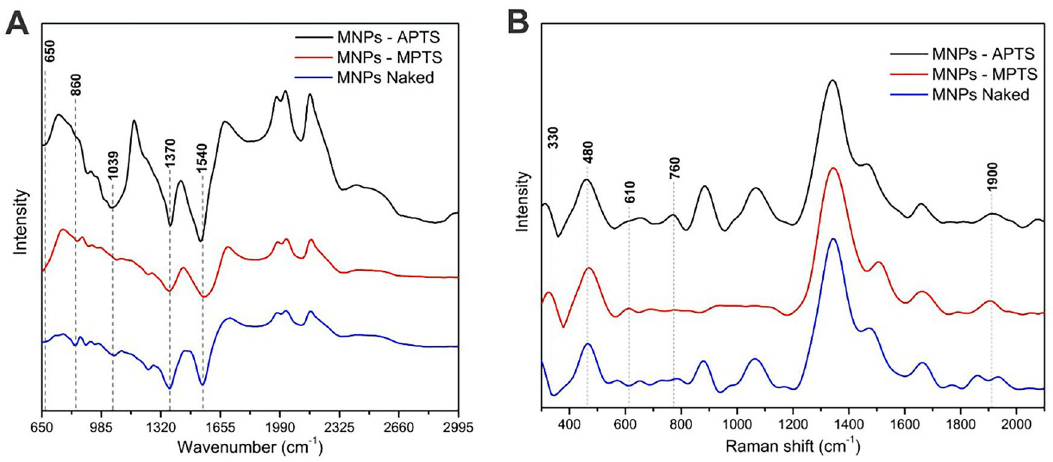
Figure 2. FTIR ( A ) and Raman ( B ) spectra of naked Fe 3 O 4 MNPs and functionalized with MPTS and